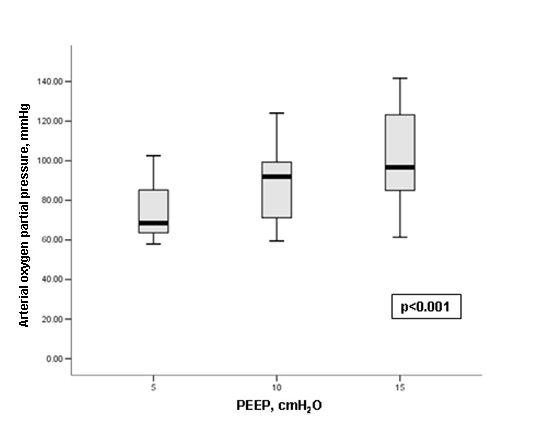
Boxplot of the arterial oxygen partial pressure at different PEEP levels (5, 10 and 15 cm H2O) in ARDS patients. {the upper and the lower boundary of the "box" (grey-shaded area) represents the 75th and 25th percentile of the data, the central black line of the " box" is the median value and the vertical lines indicate the maximum and the minimum values}